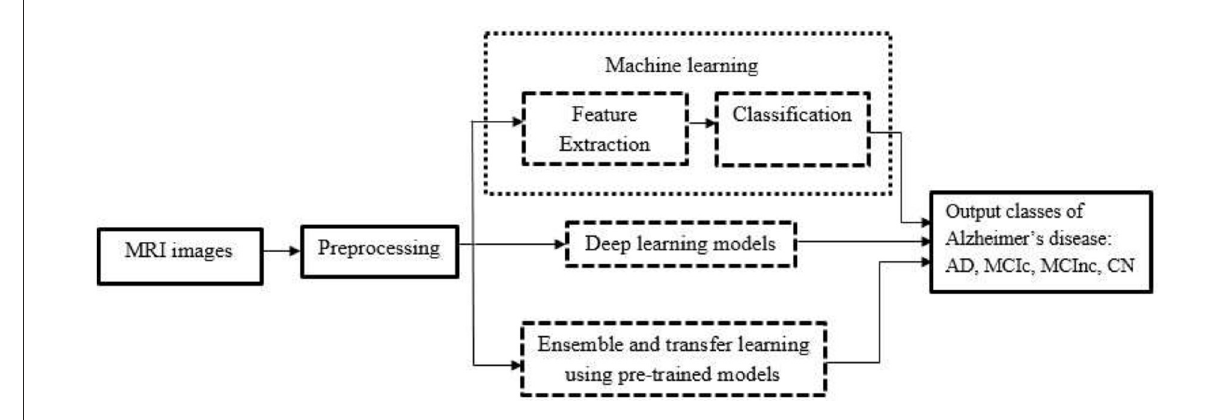
FIGURE2 Basic working flow of computer-based